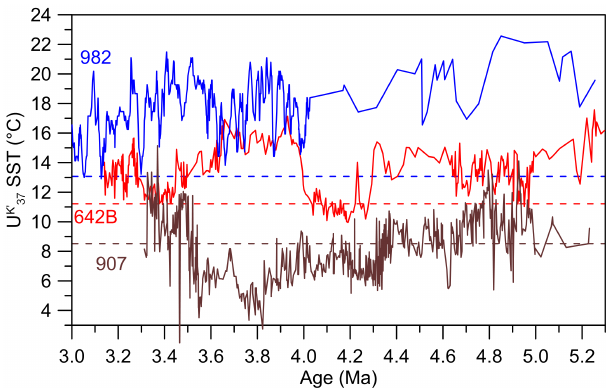
Figure 4. Sea surface temperature records from ODP Site 982 (blue; 4 to 3Ma: Lawrence et al., 2009; 5.3 to 4Ma: Herbert et al., 2016), compared to SSTs from ODP Hole 642B (red, this study) and ODP Site 907 (brown, Herbert et al., 2016; age model revised by Clotten et al., unpublished data). Comparable averages are indicated by respective dashed lines (982: core-top data, Lawrence et al., 2009; 642B: Holocene average, Calvo et al., 2002; 907: Holocene average, this